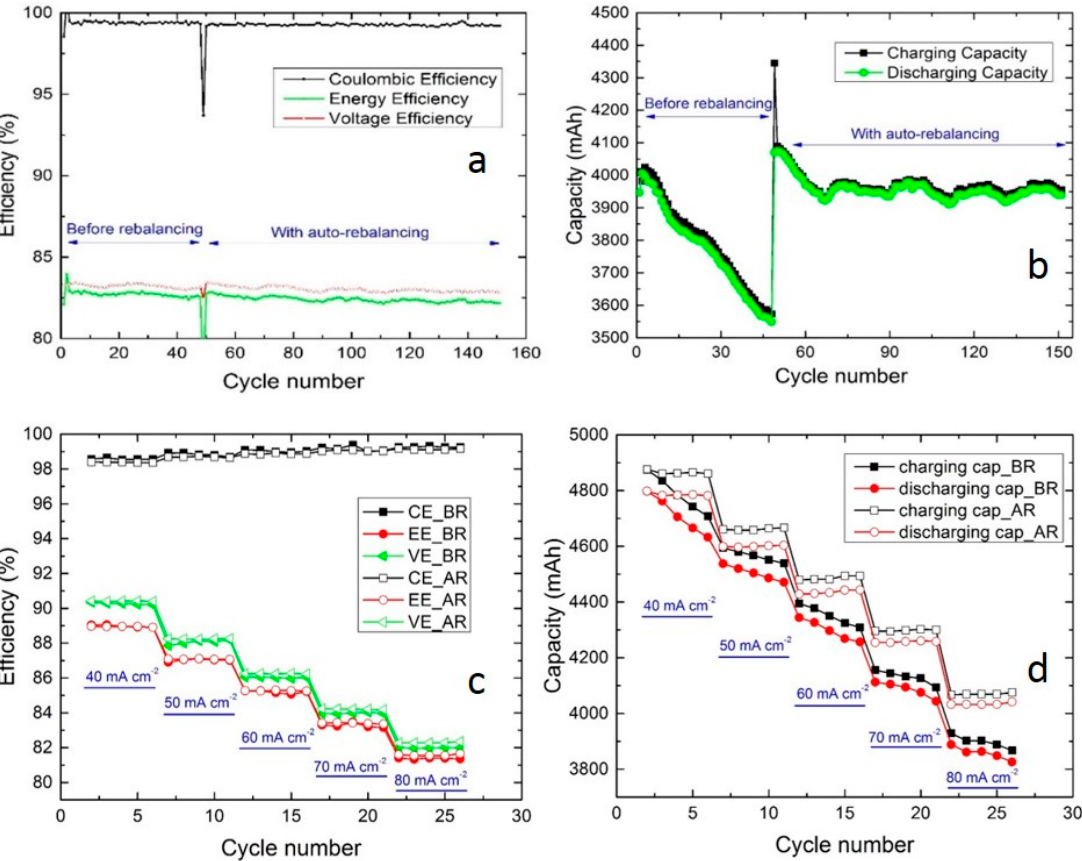
Figure 2. Comparison of efficiencies ( a ) and capacity ( b ) during cycling at 80 mA cm − 2 , and efficiencies ( c ) and capacity ( d ) during cycling at different current densities, before and after the auto-rebalancing of Stack A. (BR = before rebalancing, AR = after rebalancing).